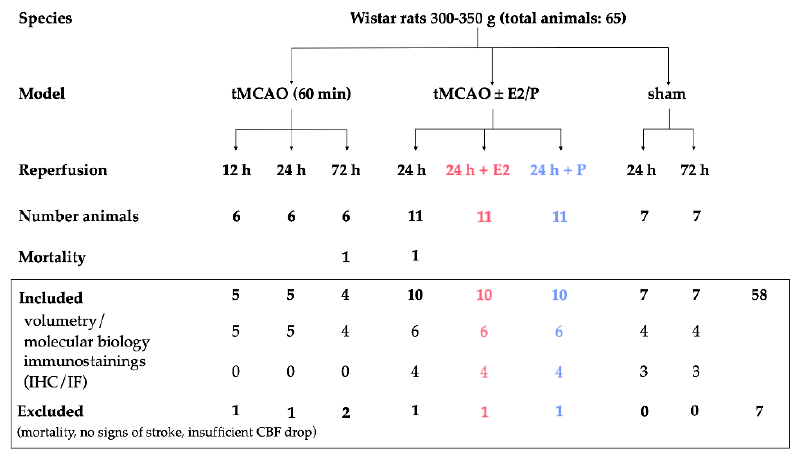
Figure 10. Overview of animal numbers used in the study and allocation to experimental groups. Note that for volumetric evaluation of infarct volumes and molecular analysis, we utilized the same animals per group, except for one animal being excluded for molecular analysis due to a particular large infarct size compared to the other rats in the group. For IHC and IF, we used the same animals for the sham and 24-h vehicle. tMCAO–transient Middle Cerebral Artery occlusion; E2–17 β -Estradiol;